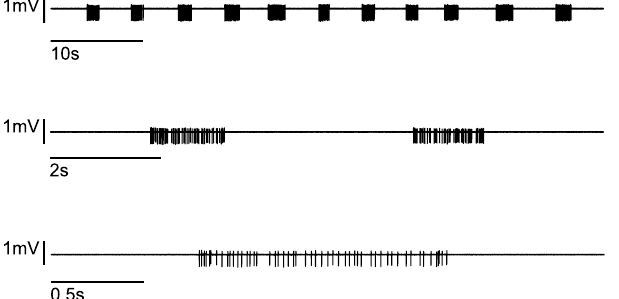
Figure 1. Original recording from a neocortical slice culture. An extracellular recording from an organotypic murine slice culture is displayed at three different time scales. The recorded signal was band-pass filtered (200– 2000 Hz) to separate action potentials from local field potentials. Upper row: One minute recording of neuronal activity: eleven up states (phases of high frequency action potential firing) are separated by neuronal silence (down states). Middle row: Ten seconds of the trace given above at higher temporal resolution. Two up states can be identified, halted by neuronal silence. Lower trace: a single up state at high temporal resolution, single action potentials can be